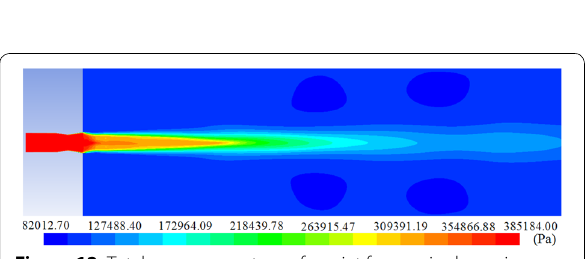
Figure 12 Total pressure contour of gas jet from a single engine